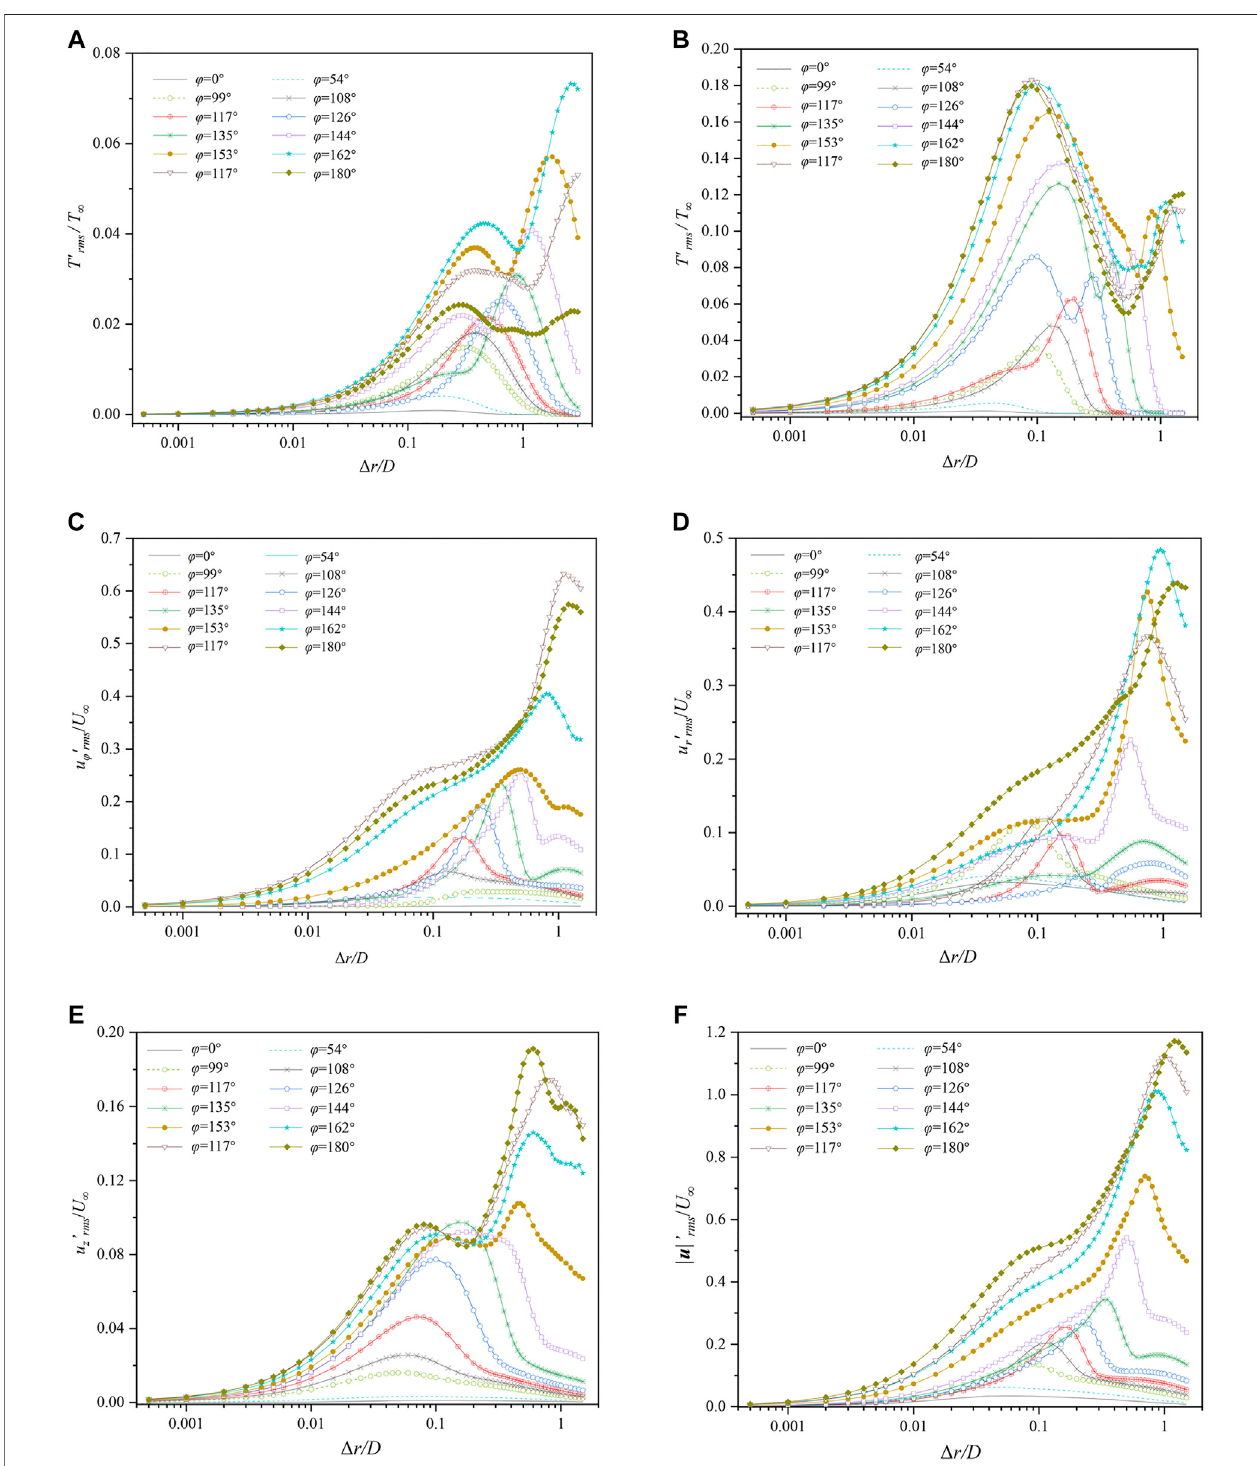
FIGURE9| Distributionsofseveralvariablesalongdifferentanglesnearthecylinderwall. (A) T ′ rms / T ∞ forthecaseofLBE; (B) T ′ rms / T ∞ forthecaseofair; (C) u φ ′ rms / U ∞ , where u φ means the circumferential component of velocity; (D) u r ′ rms / U ∞ , where u r means the radial component of velocity; (E) w ′ rms / U ∞ ; (F) | u | ′ rms / U ∞ .